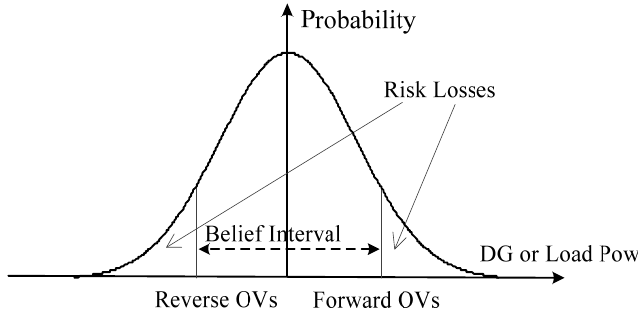
Figure 3. The risk losses of bidirectional OVs.